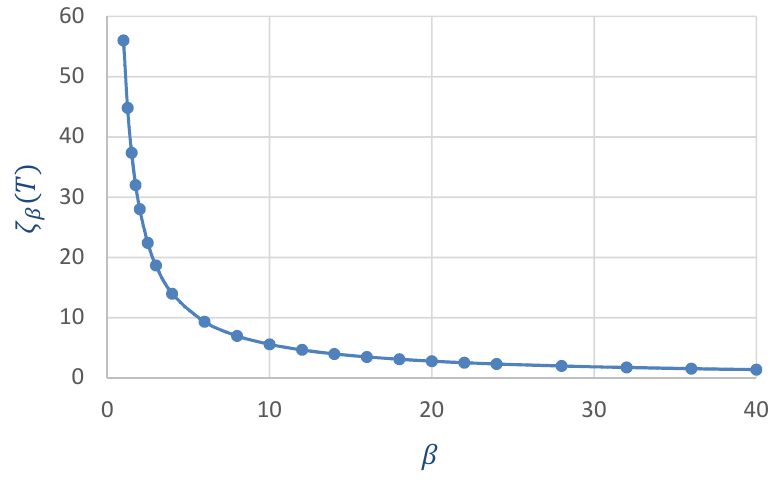
Figure 3. Dependency of the sum of pollution stocks x i ( T ) on β .